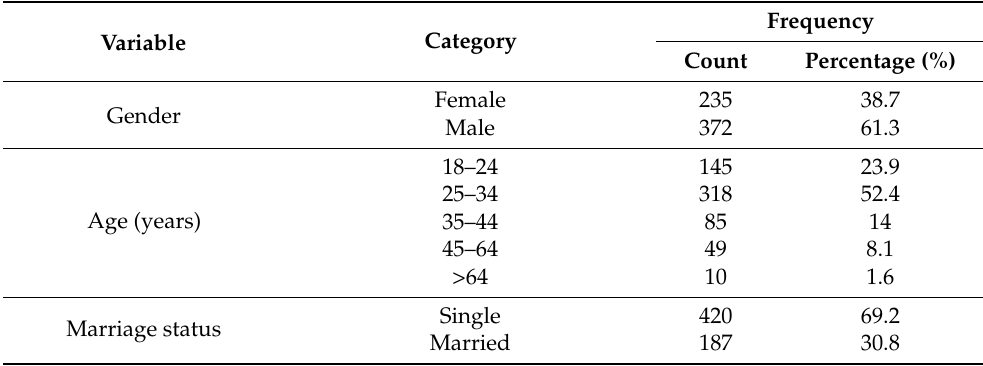
Table 4. Frequency analysis of explanatory variables: Socio-Demographic and Household Related